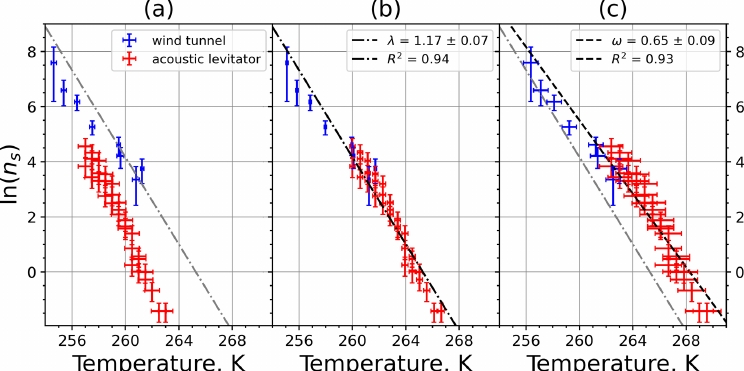
Figure A6. (a) Composite INAS density spectrum of feldspar from the uncorrected M-WT (blue) and M-AL (red) measurements. Panels (b) and (c) show the temperature-corrected data points from the M-WT and M-AL experiments based on λ and ω , respectively. The dash-dotted line in (c) is the regression line on corrected data points obtained by employing the optimal λ value as in (b)